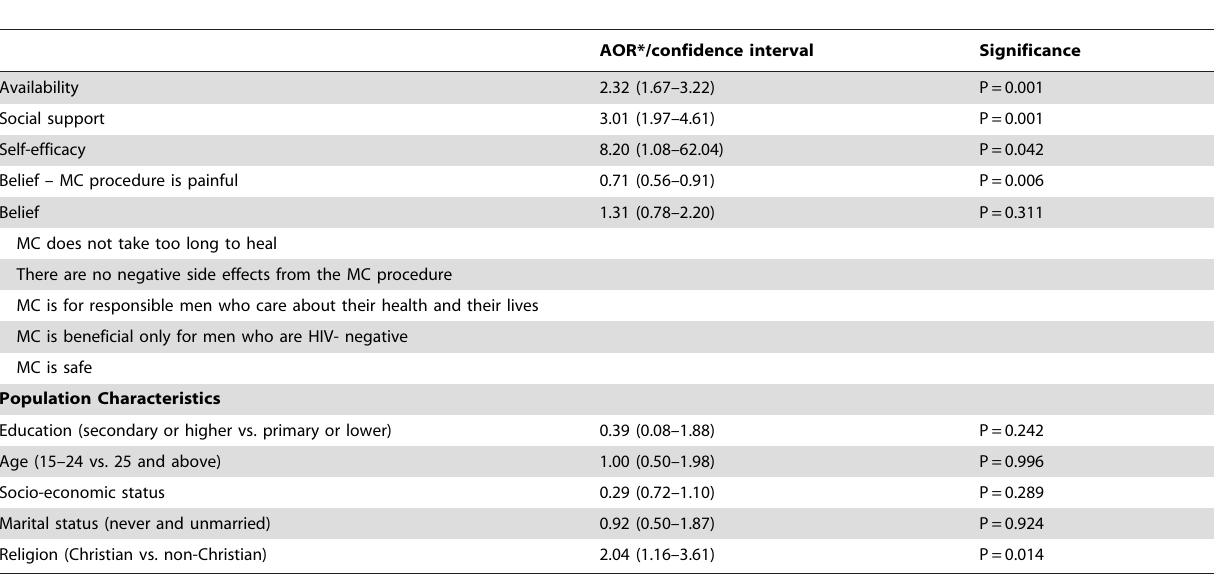
Table 6. Logistic regression for predictors of male circumcision uptake among adult males 15–49 years (outcome variable defined as males who were actually circumcised compared to those intending to be